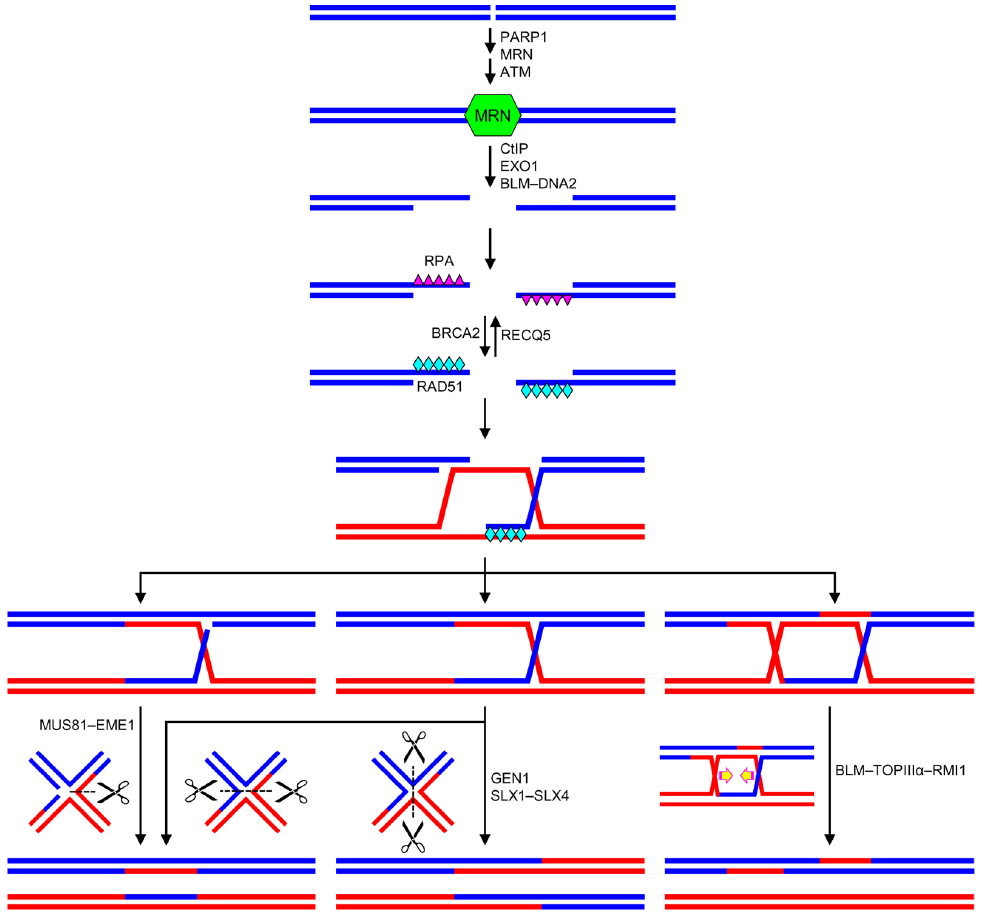
Figure 4. Principal scheme of homology-directed recombination in human cells. MRN is recruited and activated in a PARP1- and ATM-dependent manner (Figure 3). Next, CtIP, EXO1, and BLM– DNA2 trim the break ends, forming recombinogenic 3 ′ -terminal single-strand tails, which are quickly covered by RPA. BRCA2 induces the exchange of RPA for RAD51 and strand invasion. After DNA synthesis and ligation, Holliday junctions are resolved by GEN1, SLX1–SLX4 (regular junctions), MUS81–EME1 (junctions with a nick), or BLM–TOPIII α –RMI1 (fusing two junctions).